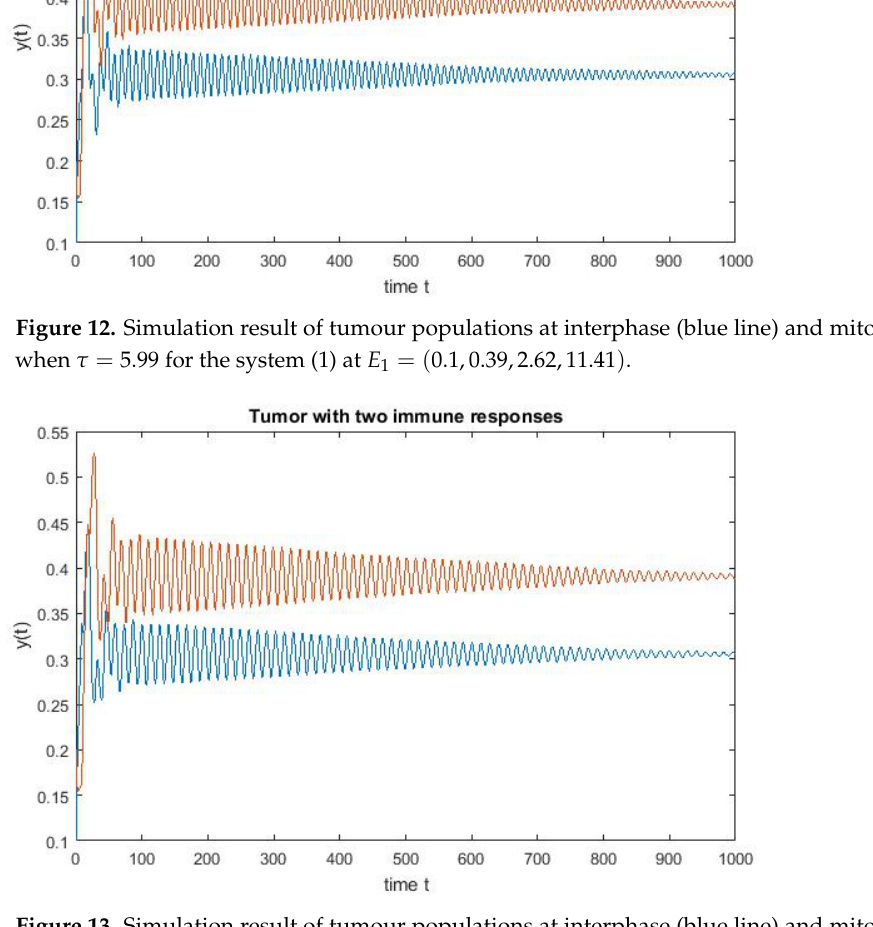
Figure 13. Simulation result of tumour populations at interphase (blue line) and mitosis (red line) when τ = 8.5669 for the system (1) at E 1 = ( 0.1,0.39,2.62,11.41 )